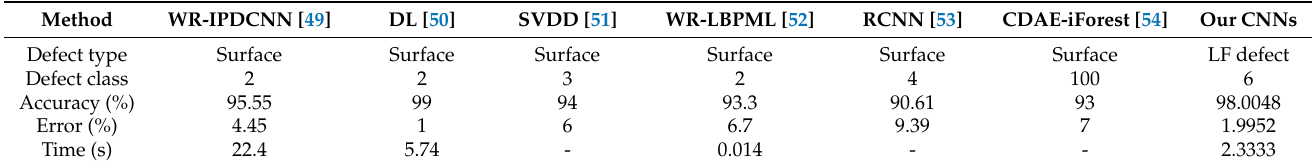
Table 5. Comparison of wire rope defect recognition results by other related algorithms.